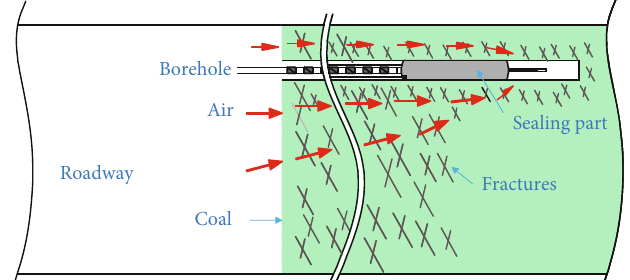
Figure 1: Air leakage in boreholes for gas